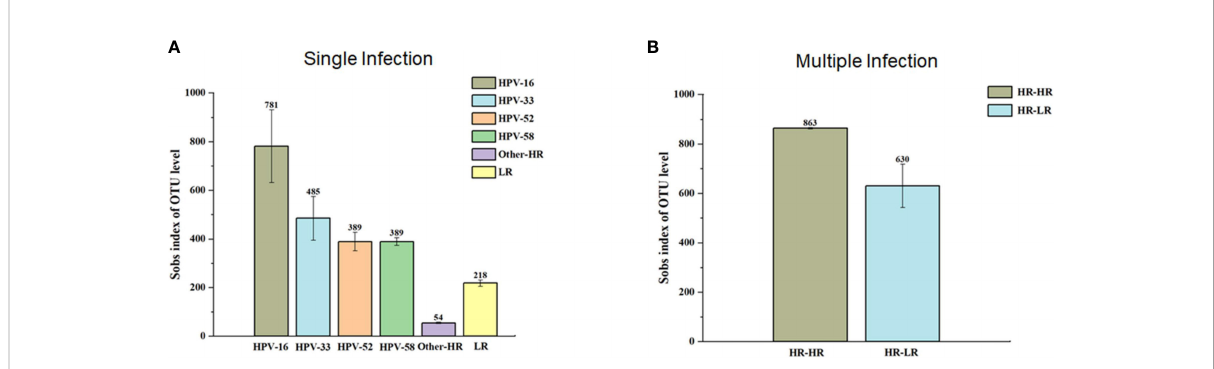
FIGURE 3 The a -diversity (Sobs index of OUT level) between single infection group (A) and multiple infection (B) groups. In single infection group, samples with HPV-16 infection presented the highest a -diversity in contrast to HPV-33, 52, 58 and others. In multiple infection groups, the highest a -